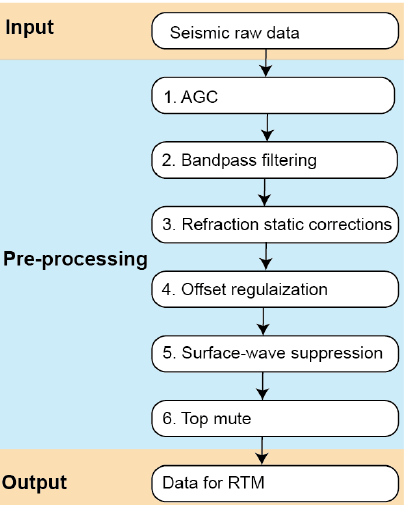
Figure 2. The six-step data pre-processing workflow for the RTM imaging. In this study, offset regularization and surface-wave sup- pression had the most significant